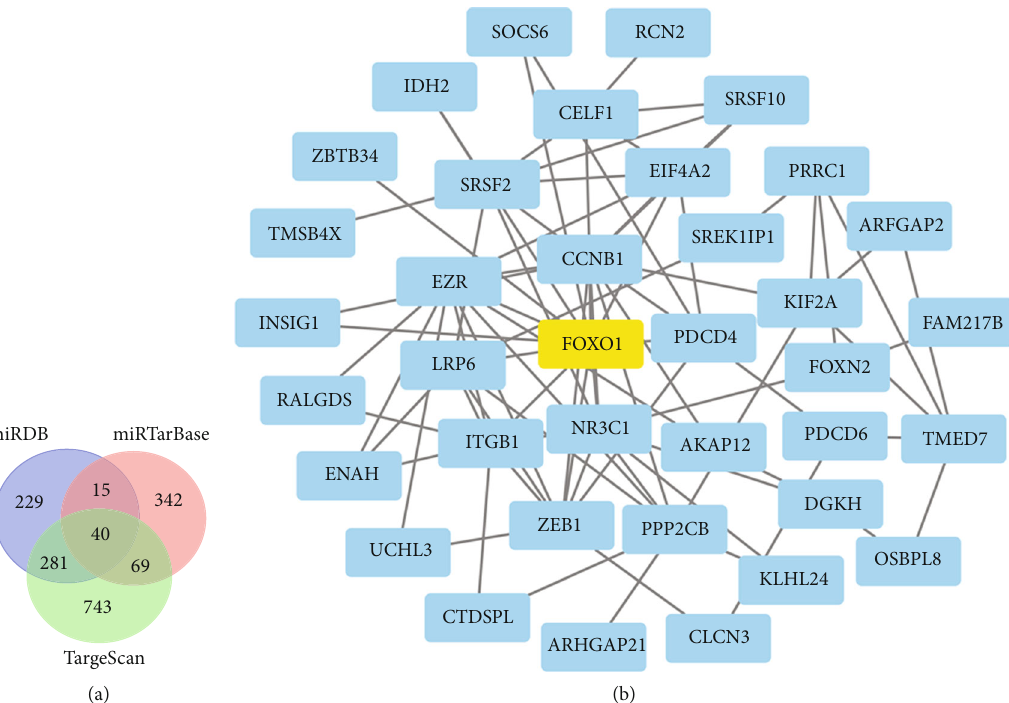
Figure 7: Bioinformatics analysis of the potential target genes of miR-183-5p. (a) The potential target genes of miR-183-5p were predicted in Targetscan7.1, miRDB, and miRTarBase platforms. (b) PPI network analysis showed the Foxo1 with high degrees of connectivity in potential target genes.